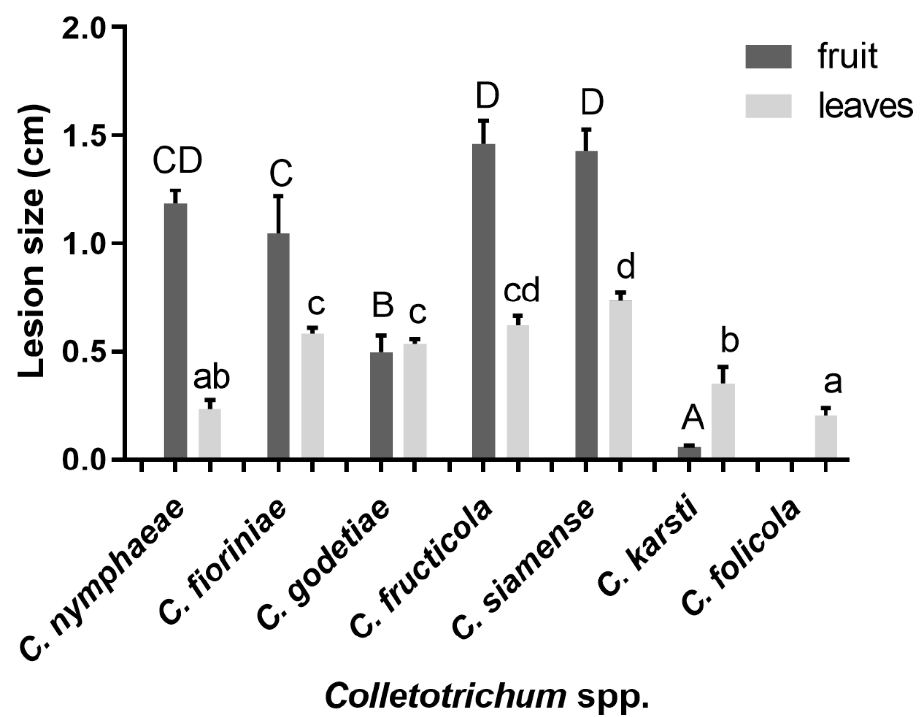
Figure 16. Lesion size on peach fruit and leaves of seven Colletotrichum spp. in the six days after inoculation. C. nymphaeae isolates FJFZ 1, HBJM 1-1, HBWH 3-2, HBYC 1, SCCD 1; C. fioriniae isolates GZTR 7-1, JXJA 1, JXJA 6, ZJLS 1, ZJLS 11-1; C. godetiae isolates YNHH 1-1, YNHH 2-1, YNHH 4-1, YNHH 7-2, YNHH 9-1; C. fructicola isolates GDHY 10-1, GDSG 1-1, GDSG 5-1, GZTR 10-1, GZTR 13-1; C. siamense isolates HBSJZ 1-1, HBSJZ 3-1, HBSJZ 5-1, HBSJZ 7-1, SDQD 10-1; C. karsti isolates YNHH 3-1, YNHH 3-2, YNHH 5-2; C. folicola isolates YNHH 2-2, YNHH 10-1. Letters over the error bars indicate a significant difference at the p = 0.05 level. Capital letters refer to fruit and lowercase letters to leaves.